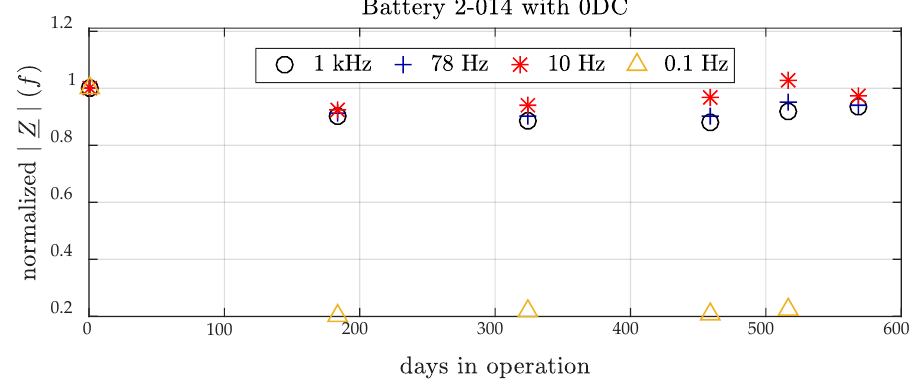
Figure A1. Increase of the normalized impedance |Z| measured at four different frequencies (1 kHz, 78 Hz, 10 Hz and 0.1 Hz) with no superimposed DC current over time of the test for all check-ups of battery 2-014 of String 2. Table A1. Influence of charge current (here: 10.4 mA String 2 and 12.4 mA String 3) flow on impedance measurement by Hioki BT3554 at range 30 mOhm. Batteries came from charge into pause phase. Absolute deviations can differ if batteries have a discharge history or at different charge current rates. Battery